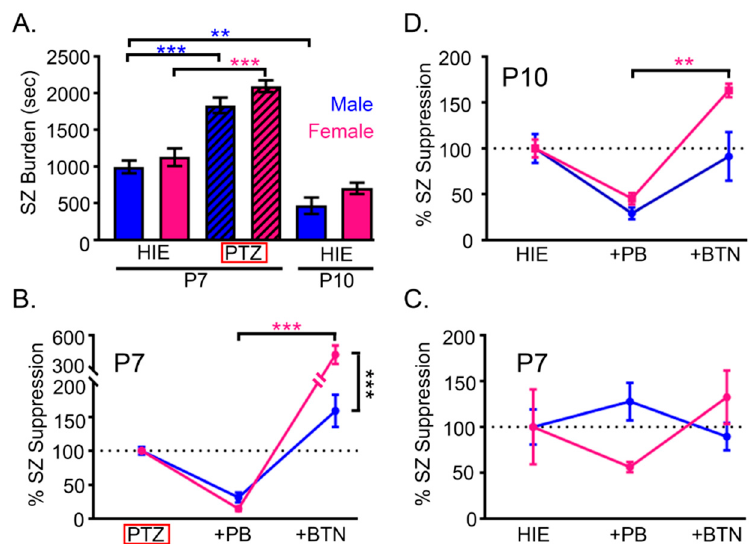
Figure 1. Sex-dependent developmental changes in neonatal seizure susceptibility and responses to antiseizure medications (ASMs) summarized from two neonatal seizure models [52,53]. (counter-clockwise) ( A ) During development males had a higher neonatal seizure susceptibility at P7 than P10 (P7 HIE Males vs. P10 HIE Males: One-way ANOVA; F 5,59 = 19.44, p = 0.0044). In contrast, females did not have significant differences in age-dependent seizure susceptibility from P7 to P10. Males and females, both had significantly higher P7 seizure burdens when neonatal seizures were induced with chemoconvulsants (PTZ) when compared to unilateral carotid ligation (HIE)-induced seizures (P7 HIE Males vs. P7 PTZ Males: One-way ANOVA; F 5,59 = 19.44, p = 0.0004; P7 Females vs. P7 PTZ Females: F 5,59 = 19.44, p < 0.0001). ( B ) PTZ induced neonatal seizures at P7 were responsive to phenobarbital (PB) at 1 h after the initial PTZ injection. Bumetanide (BTN) administration at 2h resulted in significant seizure aggravation in females (P7 PB Females vs. P7 BTN Females: Two-way ANOVA; F 2,22 = 14.6, p < 0.001). Aggravation of seizures by bumetanide was dependent upon sex as females had significantly greater seizure aggravation than males (P7 BTN Females vs. P7 BTN Males: Two-way ANOVA; F 2,22 = 43.97, p < 0.001). ( C ) HIE induced seizures were non-responsive to PB in contrast to the PTZ induced seizures at P7. Neither PB nor BTN administration significantly suppressed HIE seizures in either sex. ( D ) HIE induced seizures at P10 are responsive to PB, with BTN administration significantly aggravating seizures in females (Two-way ANOVA; F 2,18 = 2.334, p = 0.007). ** signifies p < 0.01; *** signifies p <